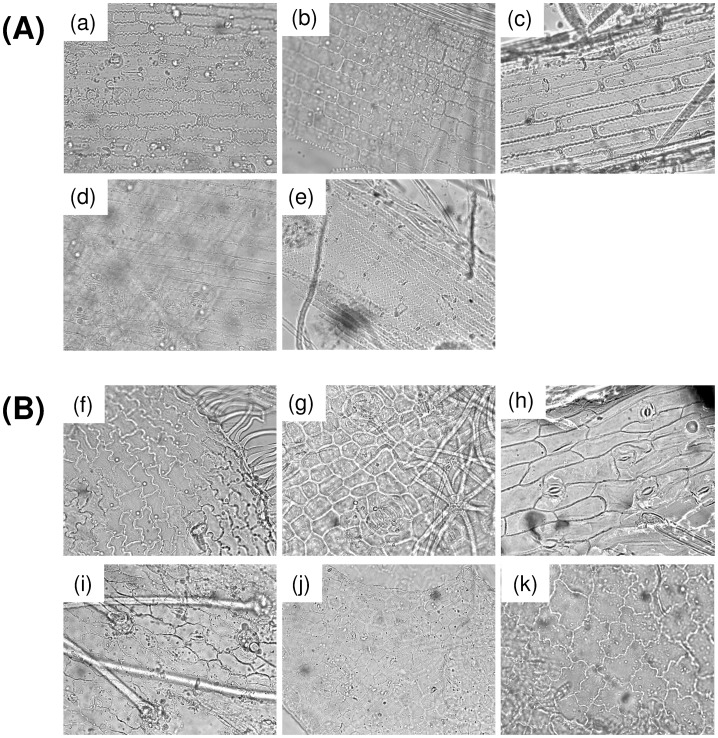
Microscopical images showing the main epidermal anatomical features of the plant species used in this study.(A) Graminoid species: (a) Arrhenatherum elatius, (b) Carex caryophyllea, (c) Festuca spp., (d) Juncus trifidus, (e) Nardus stricta; (B) Dicotyledonous species: (f) Calluna vulgaris, (g) Helianthemum nummularium, (h) Hypochaeris radicata, (i) Medicago sativa, (j) Trifolium alpinum, (k) Vaccinium uliginosum. Images were obtained under 400 x magnification.